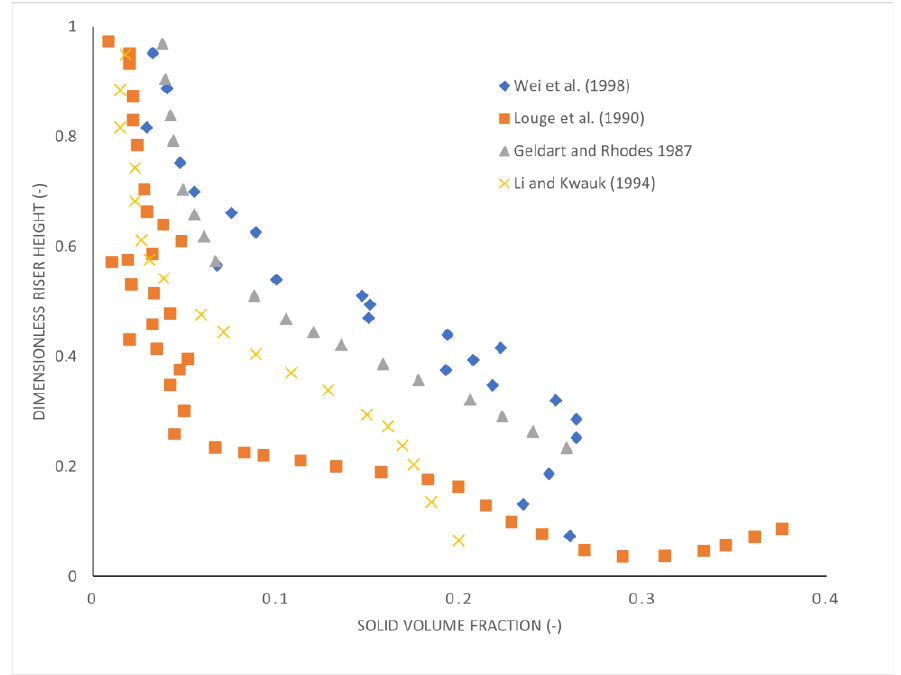
Figure 7. Axial solid volume profiles along the riser height (Redrawn from Shah et al. [7] for various gas and solid flux).